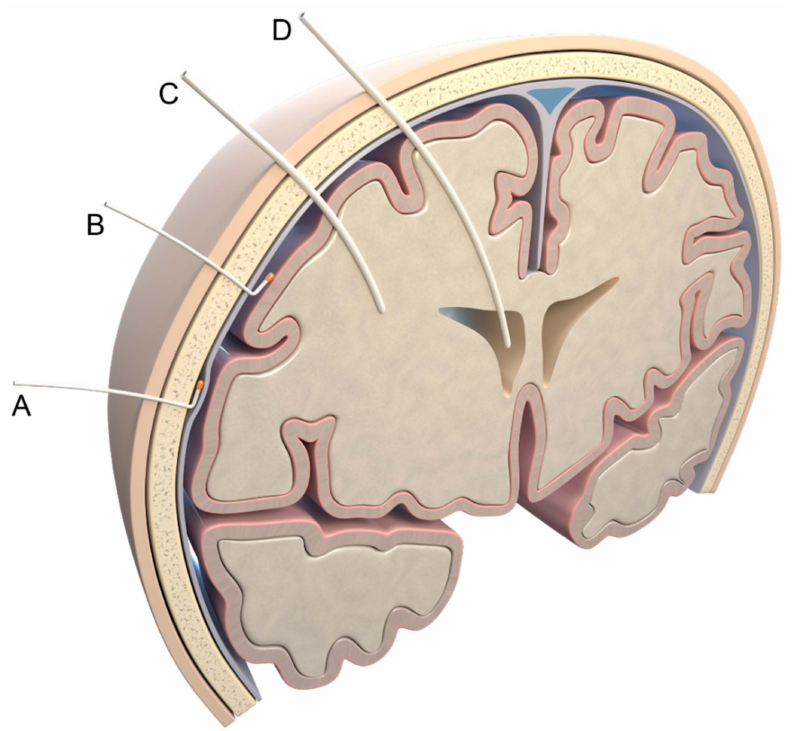
Figure 1. Invasive measurement methods. Possible localizations of pressure probes: (A) epidural; (B) subdural; (C) parenchymal; (D) intraventricular. Illustration created by J.